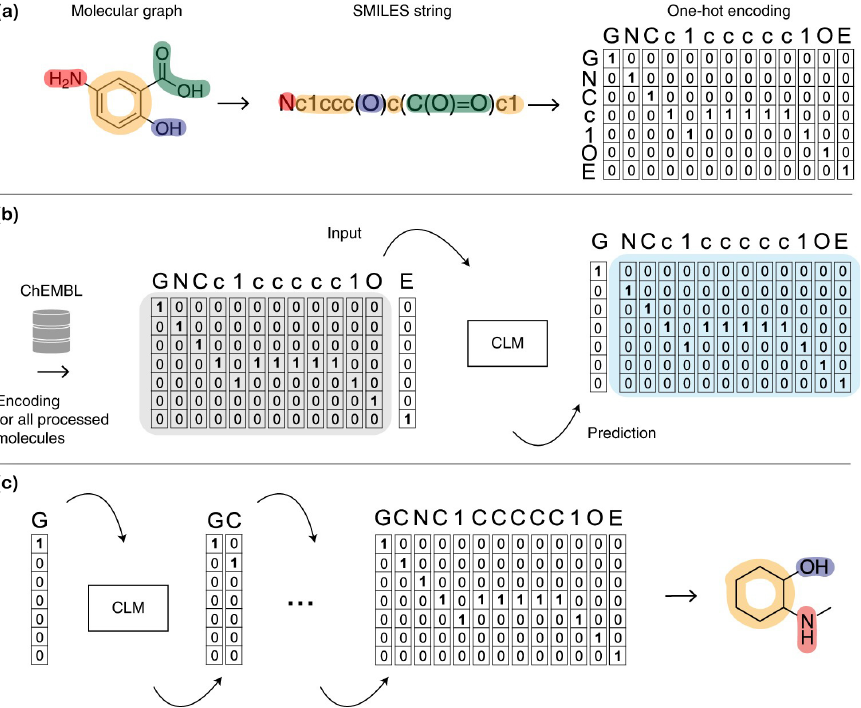
Figure 2. Chemical language model training and sampling of new molecules. ( a ) Each molecule is translated into a SMILES string. ( b ) The chemical language model learns the feature distribution of the dataset. ( c ) The chemical language model repeatedly samples tokens from the learned distribution [34]. Copyright 2020 Springer Nature Limited.